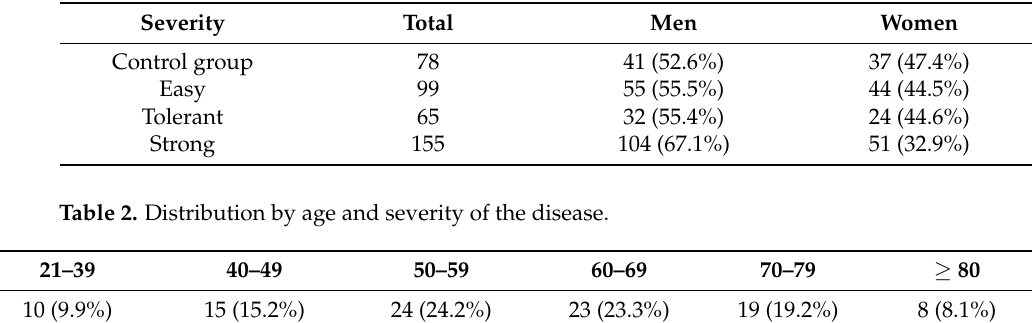
Table 1. Gender and severity of COVID-19 disease.